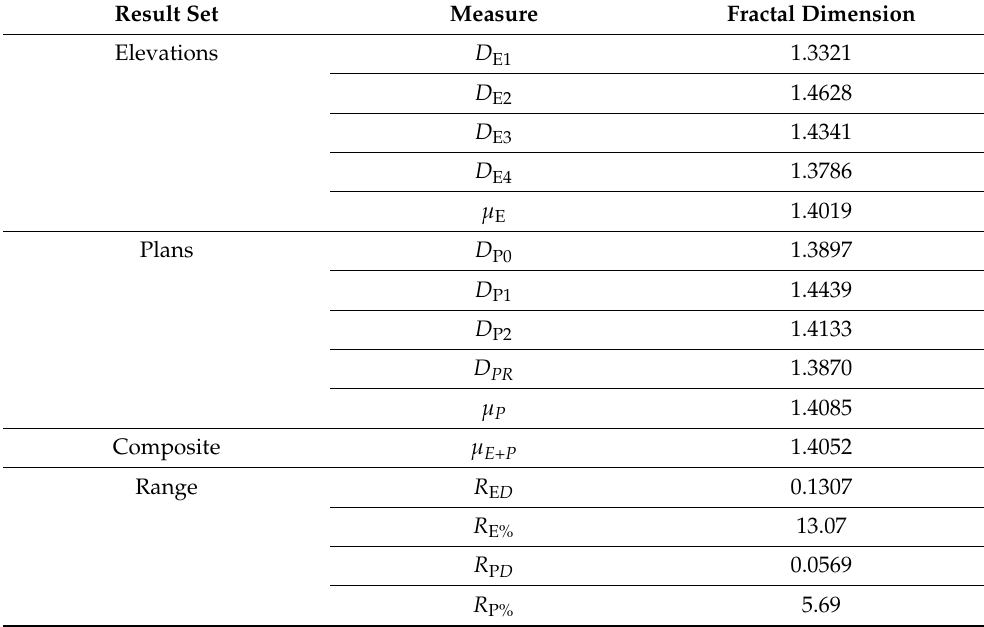
Table 3. Fallingwater